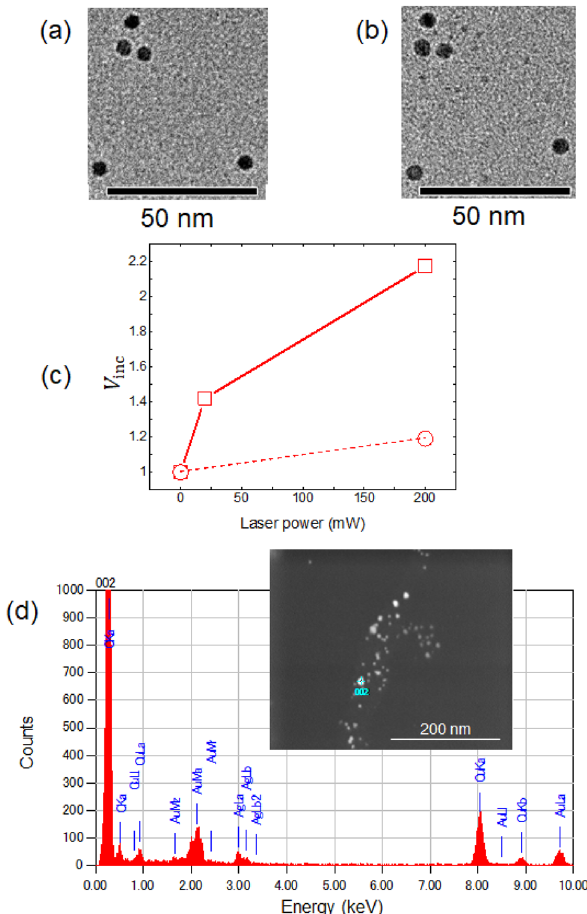
Figure 4. TEM images ( a ) before and ( b ) after 808 nm irradiation (200 mW for 15 min) without photosensitive agent. ( c ) V inc for 808 nm (200 mW for 15 min) with Irgacure 819 (squares) and without Irgacure 819 (circles). ( d ) EDS spectrum. Inset: typical TEM image after 808 nm irradiation with Irgacure